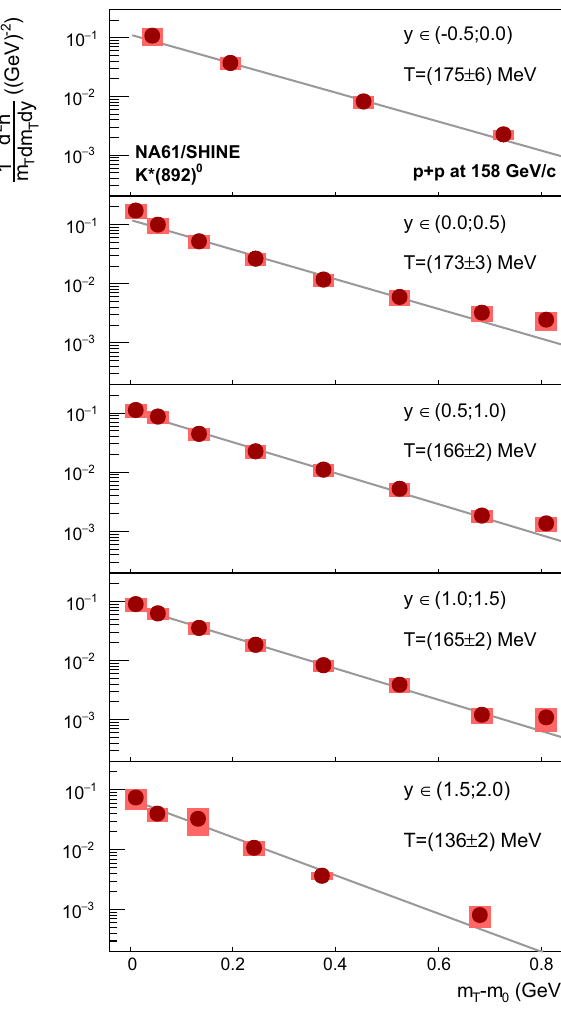
d 2 n for five bins of rapidity. m T dm T dy